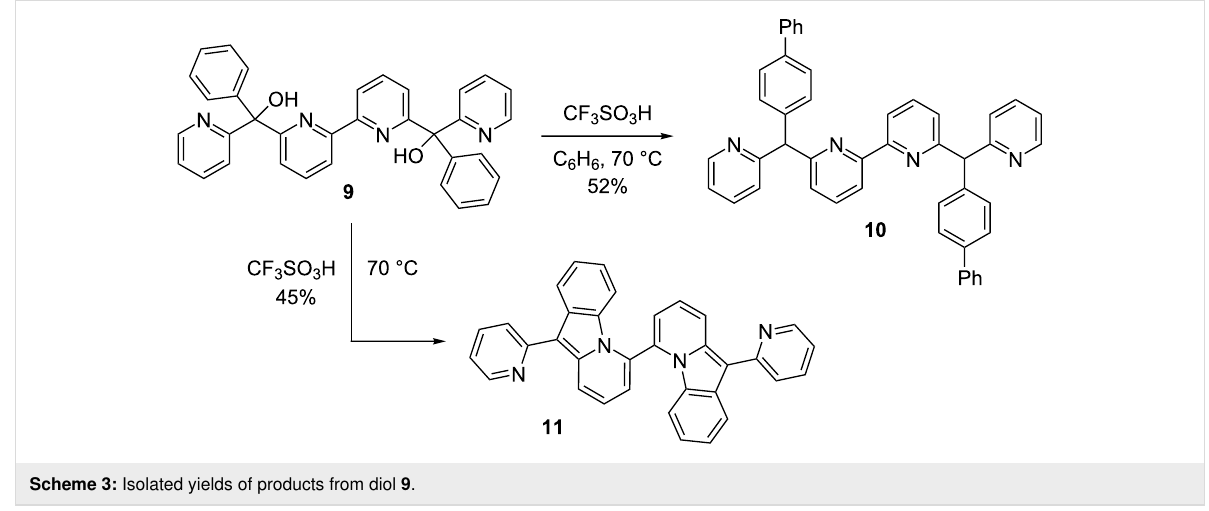
Scheme 3: Isolated yields of products from diol 9 .